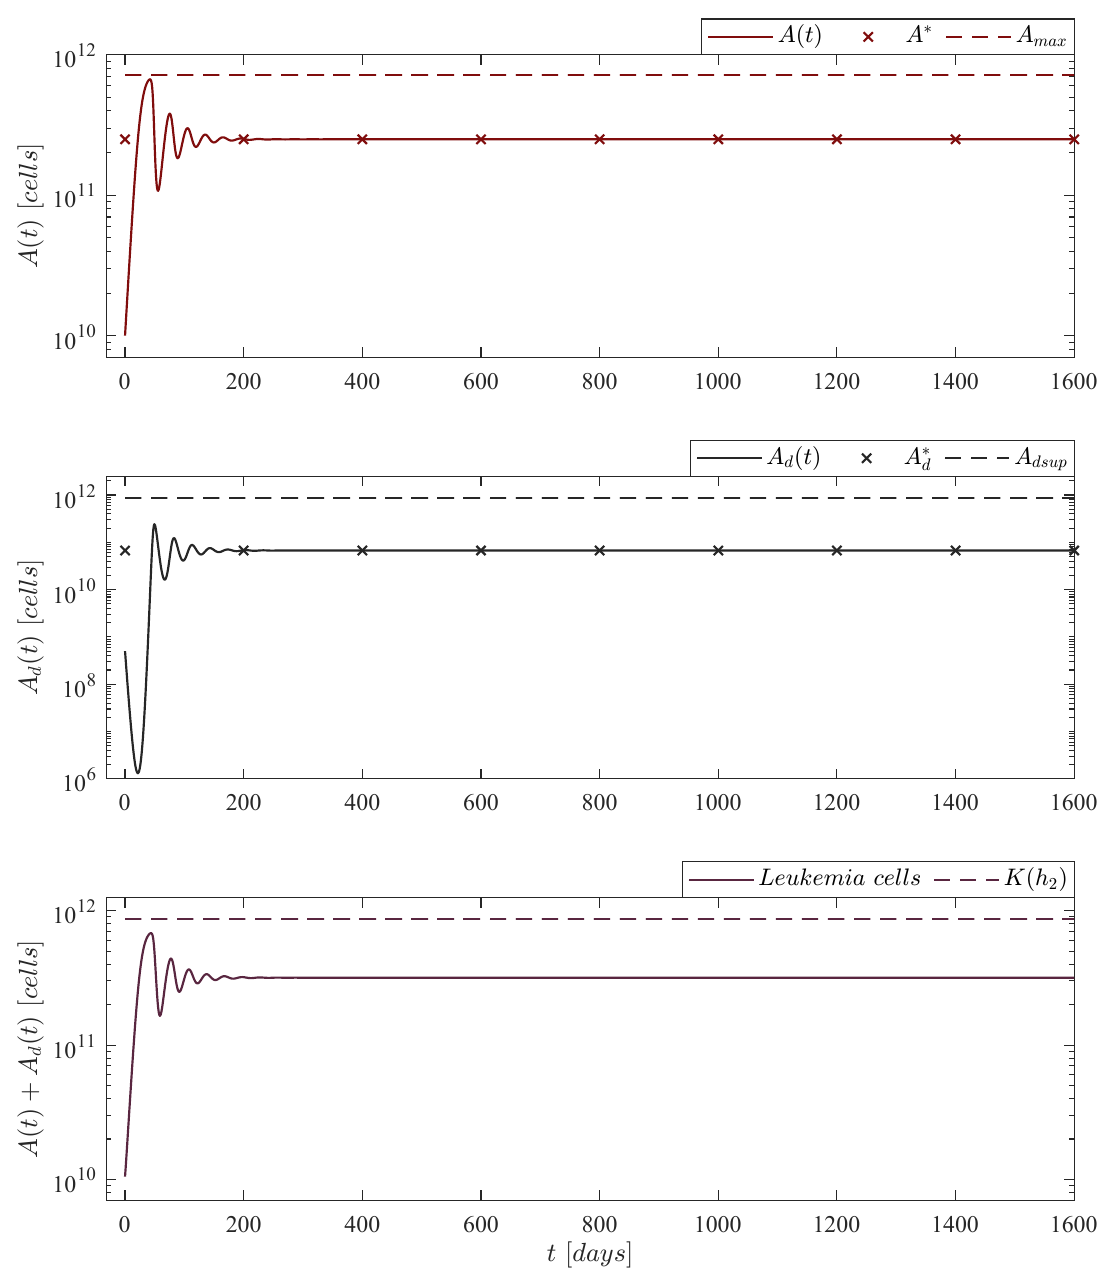
Figure 2. No treatments case. The in silico experimentation illustrates that the absolute count of live leukemia cells [ A ( t )] is of 2.5 × 10 11 , which implies 50,000 cancer cells by every µL of blood, while the final count of dead leukemia cells [ A d ( t )] represents ∼ 26.88% of this value. In the lower panel one can see that the sum of these two cells populations almost reach the maximum carrying capacity but eventually converges to a value below the upper bound given in the localizing set K ( h 2 ) . Mathematically, solutions of the live and dead leukemia cells go to the equilibrium point (cid:0) (cid:1) = (cid:0) ) (cid:1) . For this case, parameter ρ A ∗ , A ∗ µ d / µ A , ρ A ( b µ A − µ d ) / ( b µ 2 A is set to A d